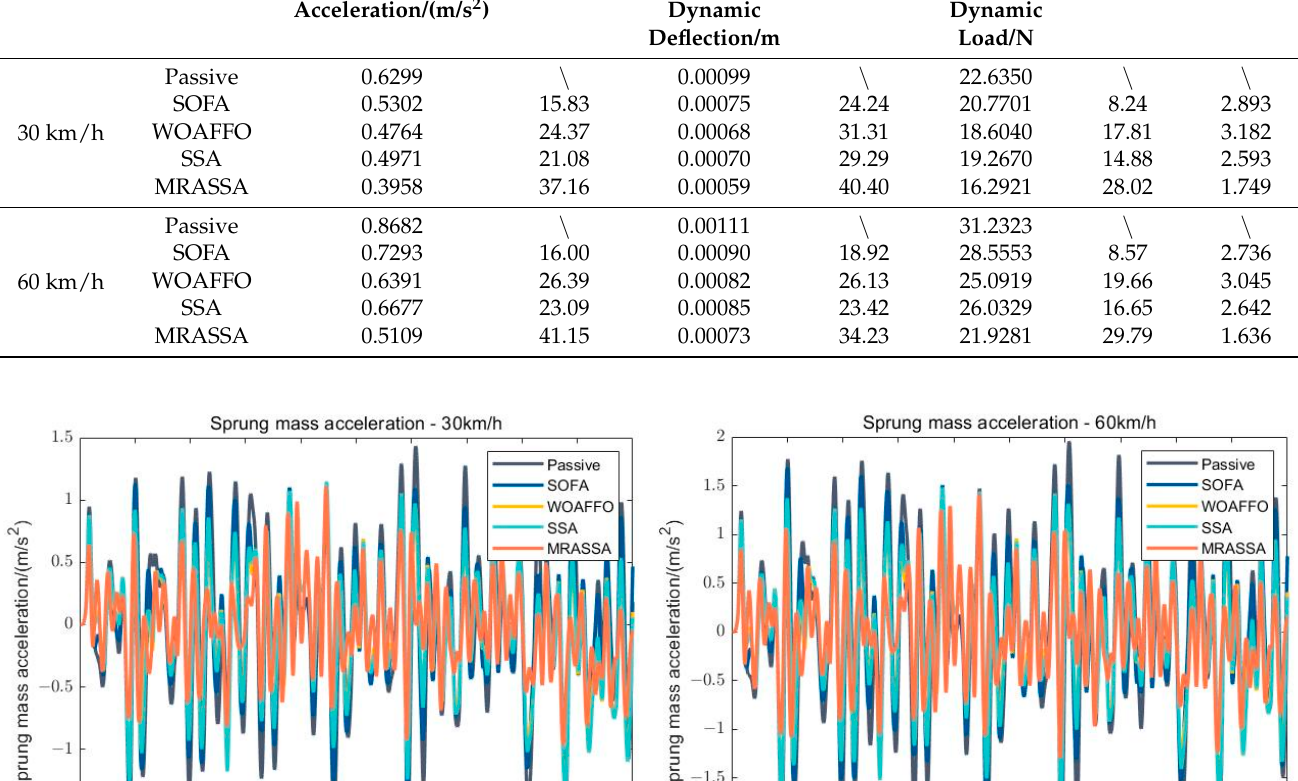
Table 4. Optimization Results for Simulation of the Random Road.